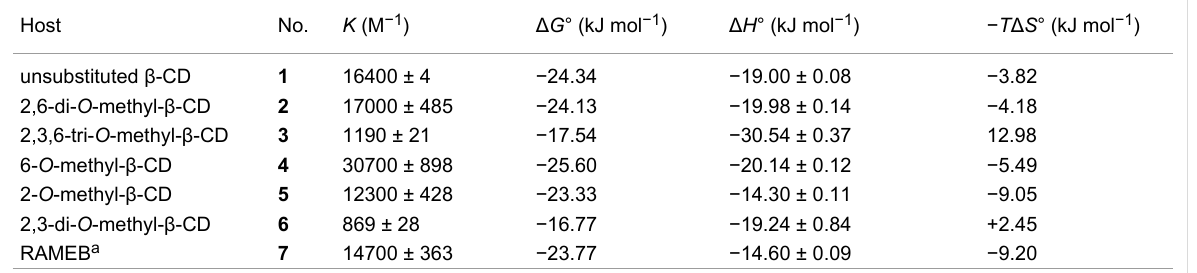
Table 1: Thermodynamics of the inclusion of 4- tert -butyl-benzoate in β -cyclodextrin 1 and its methyl derivatives 2 – 6 . Host